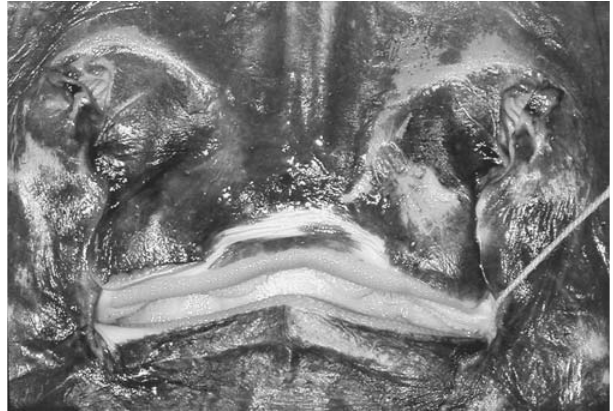
Fig. 5. Detail of nasoral region of larger male paratype of